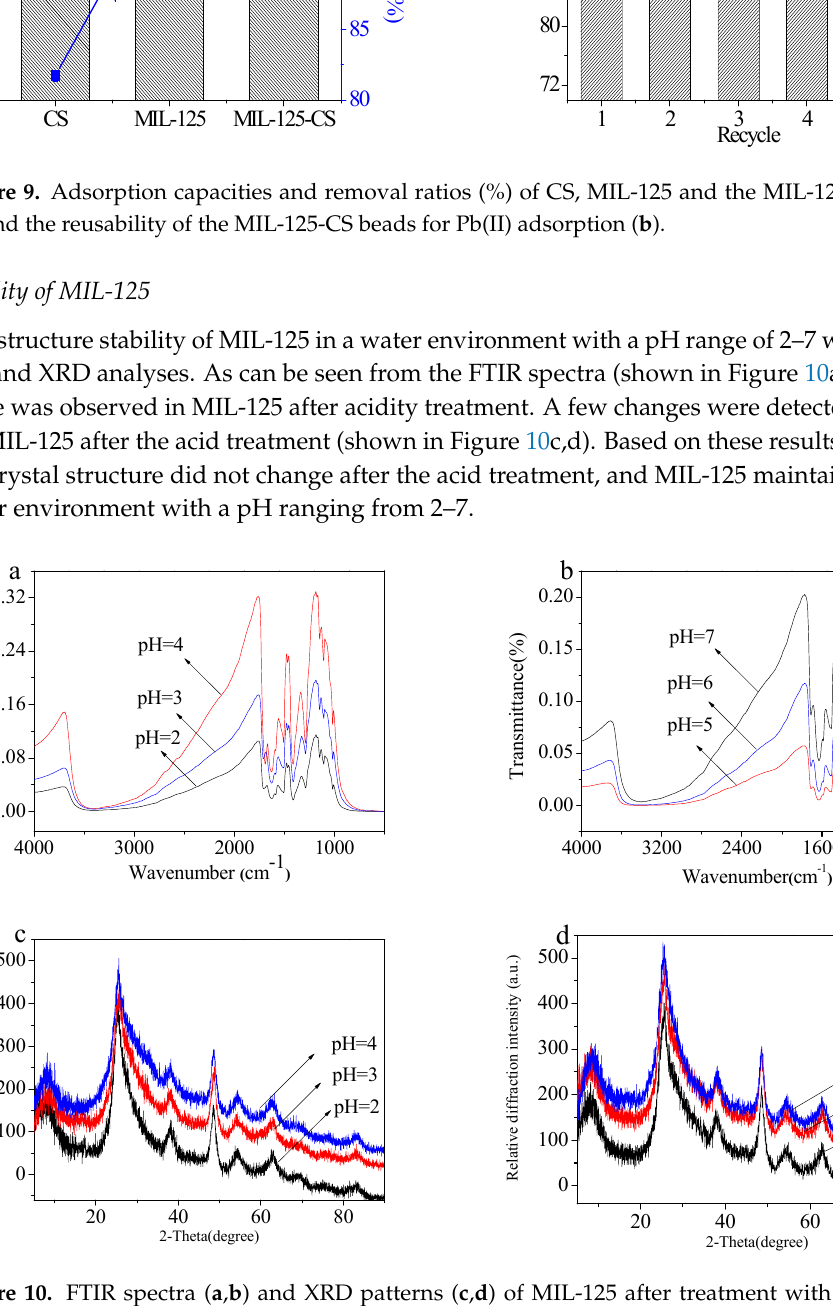
Figure 10. FTIR spectra ( a , b ) and XRD patterns ( c , d ) of MIL-125 after treatment with solution of different pH.